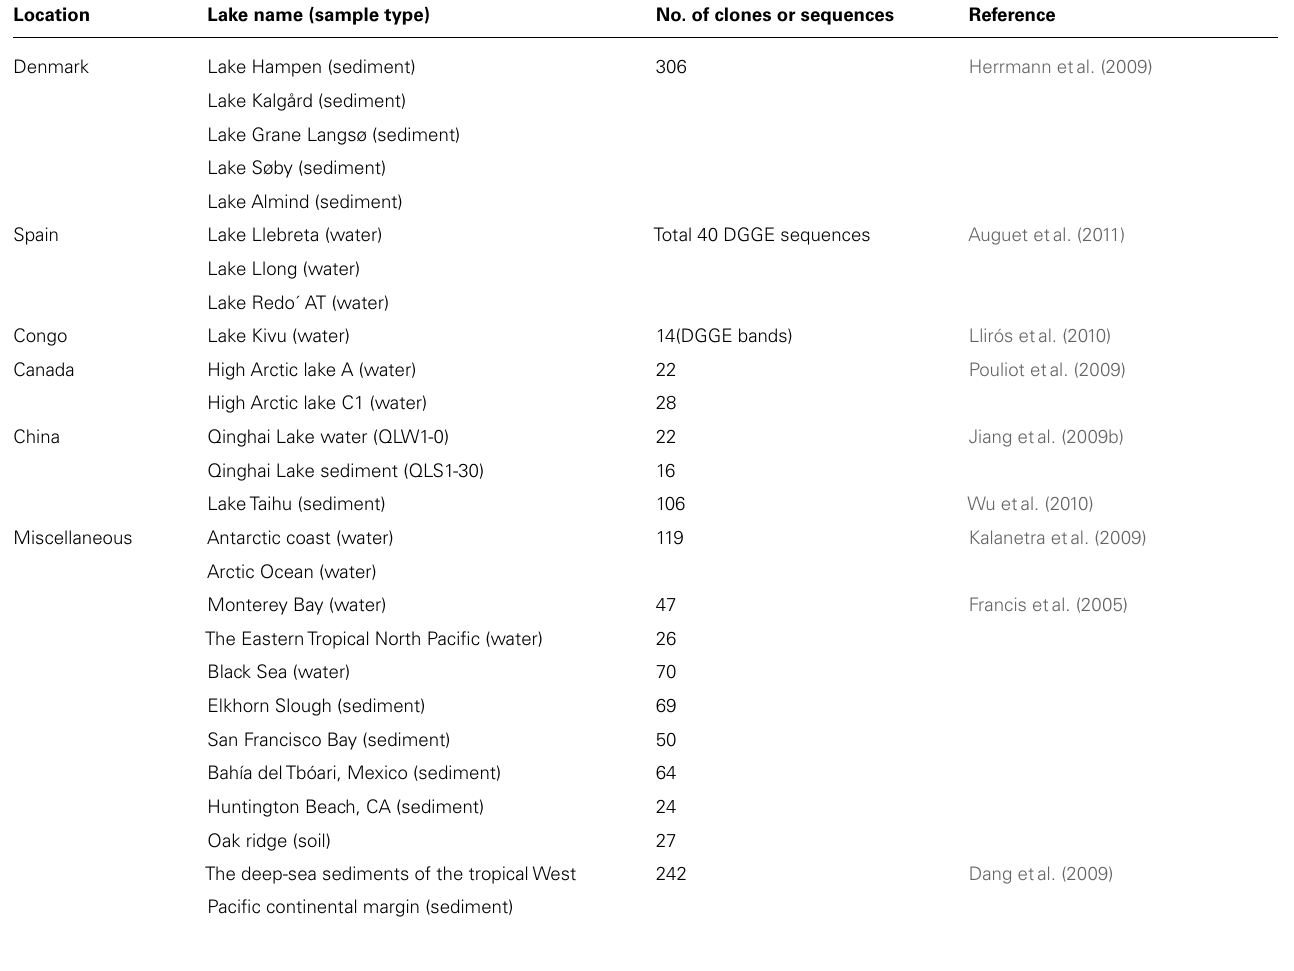
Table 1 | Summary of theAEA amoA gene sequences used for the comparison between this and other studies (theAEA amoA gene sequences were derived from the primer set of Francis etal. (2005), and the length of the amoA gene sequences was 635 bp.